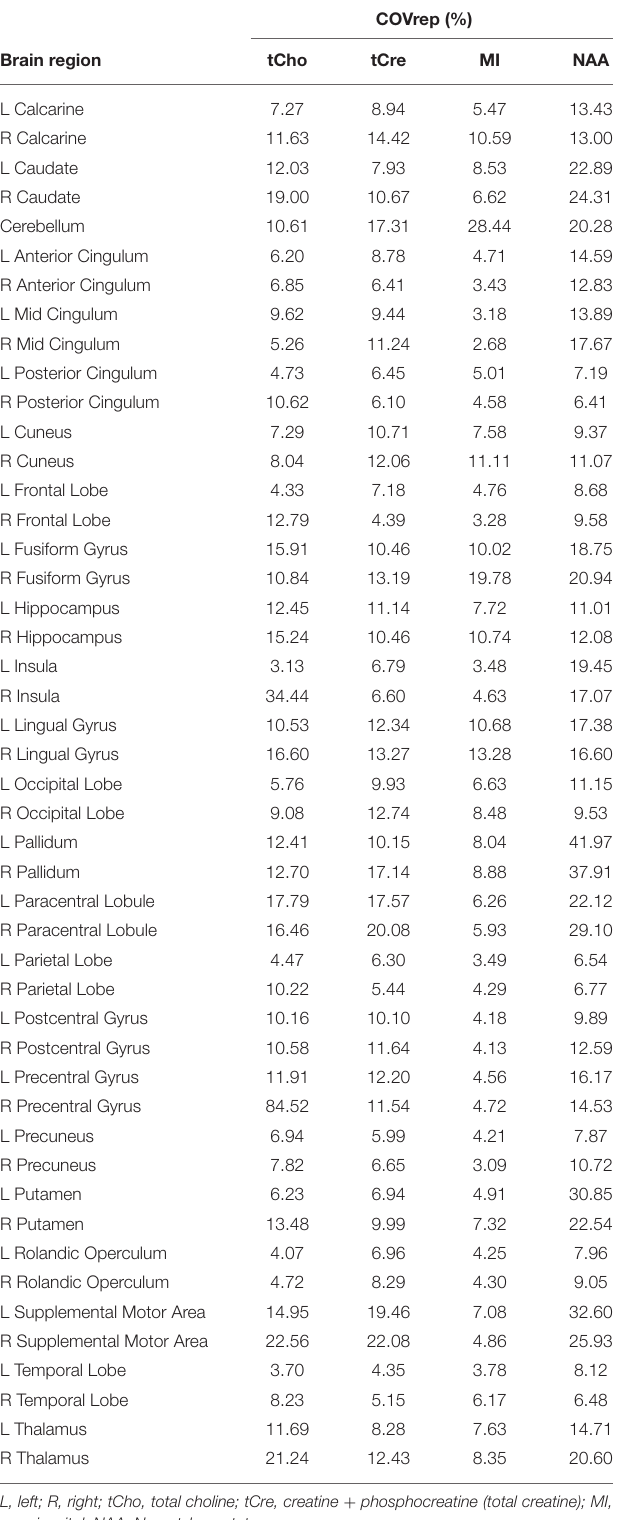
TABLE 3 | Coefficient of variation (COVrep, %) for major metabolites.